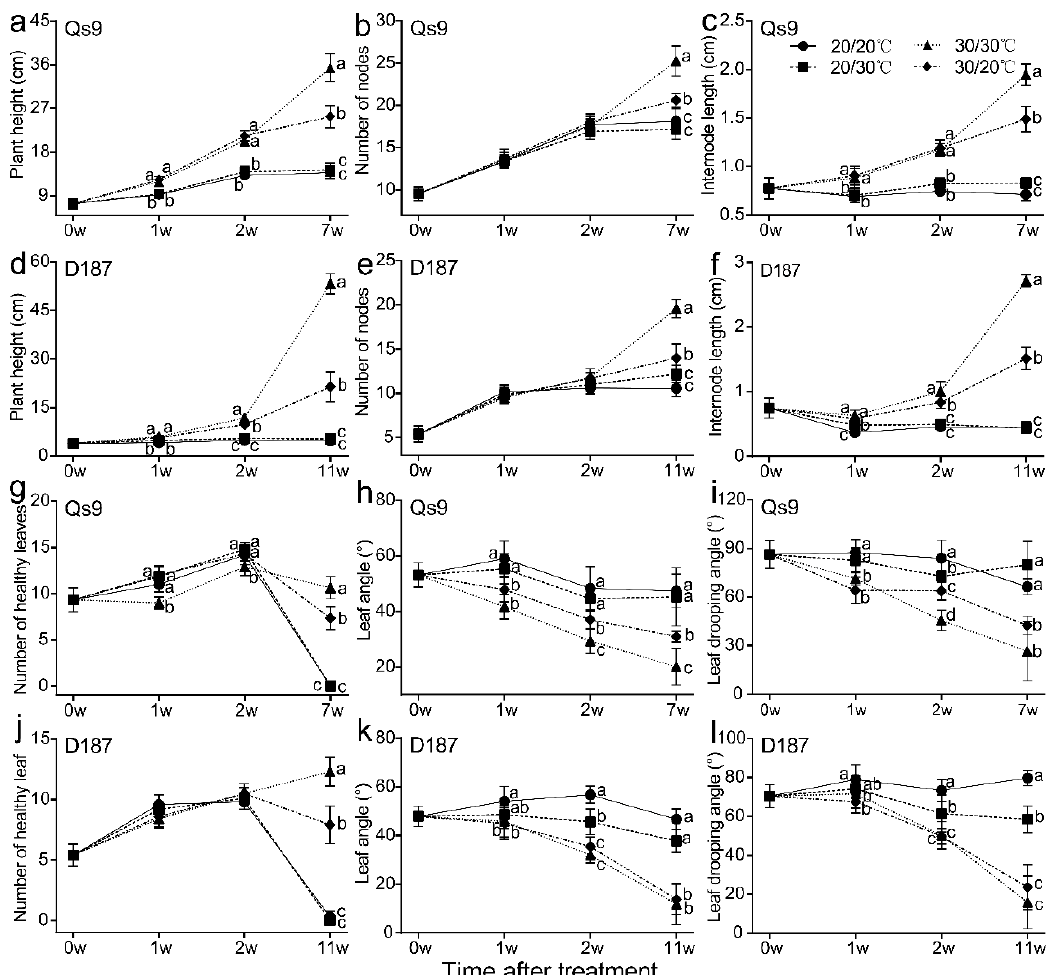
Figure 3. Measurement of stem phenotype and leaf angle under heat-stress treatment of different plant parts. ( a – c ) and ( g – i ): plant height ( a ), number of nodes ( b ), internode length ( c ), number of healthy leaves ( g ), leaf angle ( h ), and leaf drooping angle ( i ) of the Qs9 plants at the indicated time points during the treatment. ( d – f) and ( j – l ): plant height ( d ), number of nodes ( e ), internode length ( f ), number of healthy leaves ( j ), leaf angle ( k ), and leaf drooping angle ( l ) of the D187 plants at the indicated time points during the treatment. In total, 10 replicates were averaged and statistically analysed. The different lowercase letters indicate groups that are significantly different from one another.